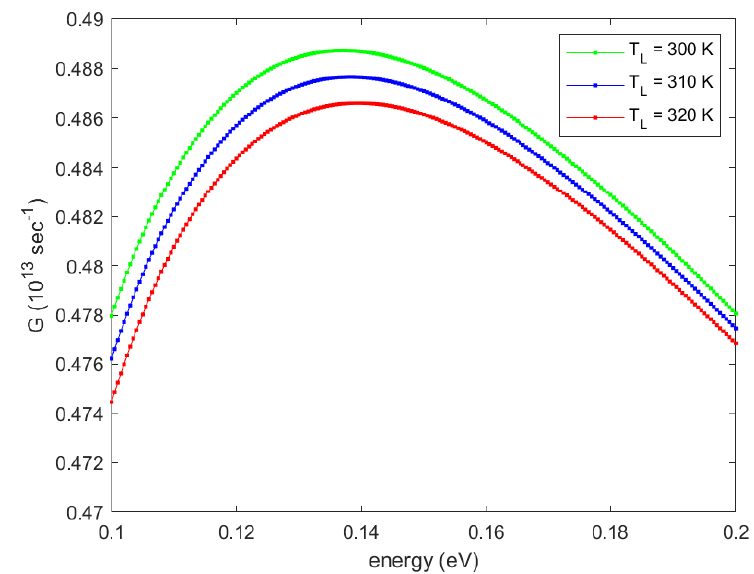
Figure 7. The function G ( ε ) ( 31 ) versus energy for some lattice temperature.